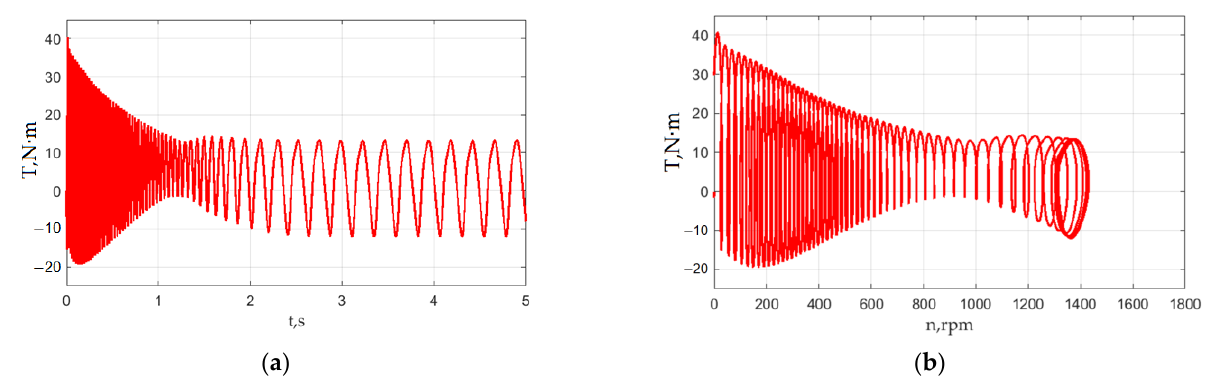
Figure 11. LSPMSM torque with fully open valve, 380 V: ( a ) Torque versus time; ( b ) torque versus speed.